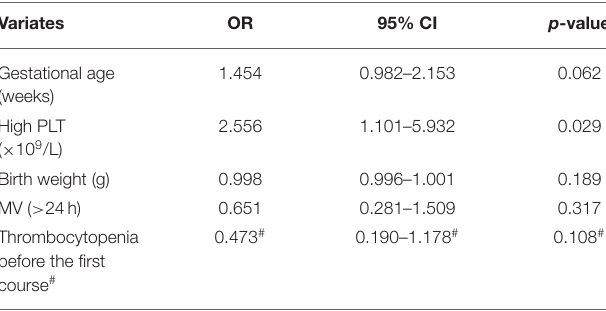
TABLE 3 | Multivariate regression analysis of successful closure of PDA by